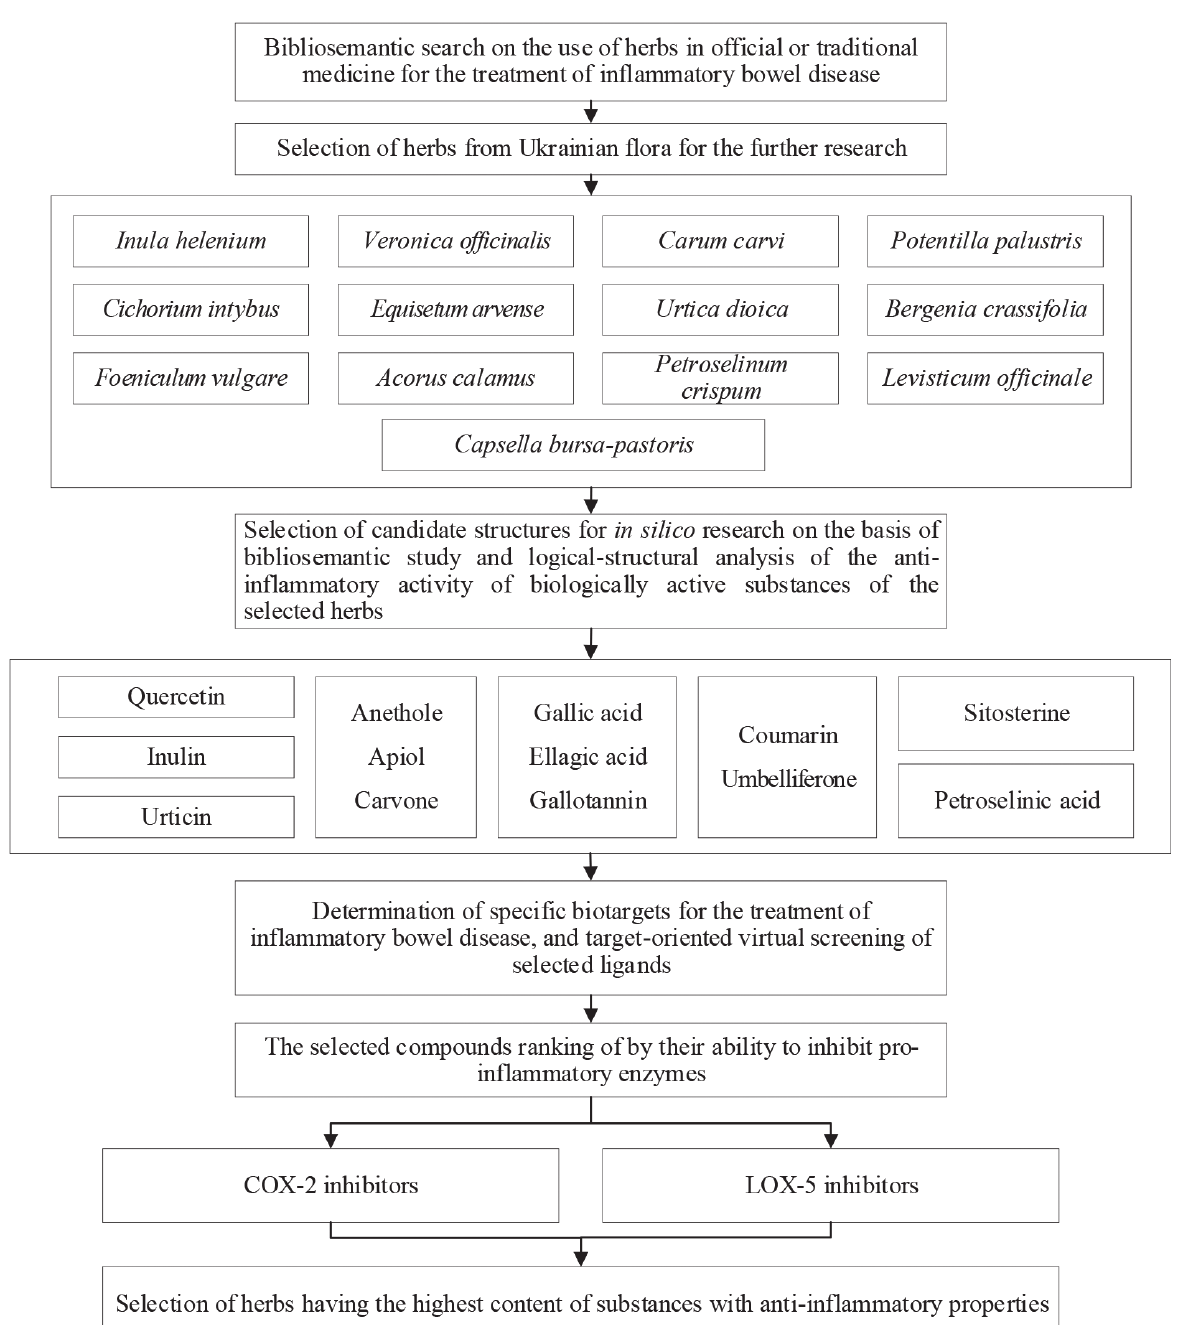
Figure 1. General algorithm of the